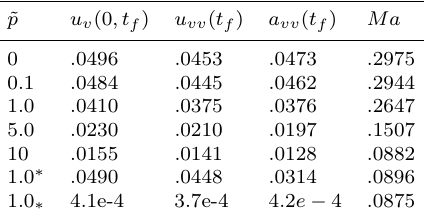
1. the filtration process for initial full container of pollutants